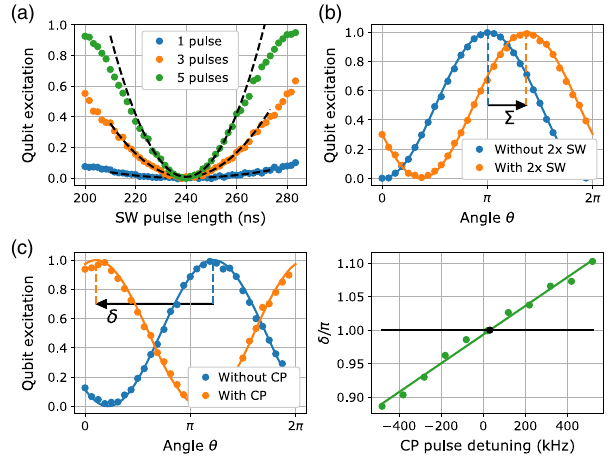
FIG. 7. Experimental data from typical gate calibration mea- surements. (a) Calibration of i SWAP pulse length. The final excitation probability of the control qubit reaches its minimum at the optimal pulse length. We extract this optimum by fitting a quadratic function in the vicinity of the minimal value. The pulse lengths obtained from measurements with 1, 3, or 5 repetitions of the pulse are consistent. (b) Calibration of i SWAP single-qubit phases. The final control qubit excitation after the Ramsey sequence shows a cosine oscillation as a function of the phase θ of the second π = 2 pulse. The shift of this curve between Ramsey sequences with and without two SW pulses gives us the phase sum Σ ¼ γ 1 þ γ 2 . (c) Calibration of c PHASE frequency. The two-qubit phase δ ¼ γ 11 − γ 01 − γ 10 is measured with a Ramsey sequence utilizing spin echo. As in (b), the phase θ of the final π = 2 pulse is varied and the shift of the obtained cosine dependence between sequences with and without the CP pulse is the desired phase δ . We perform this measurement for varying detuning of the CP pulse and find a dependence which is well approximated by a linear function. Using this fit, we obtain the optimal detuning where δ ¼ π